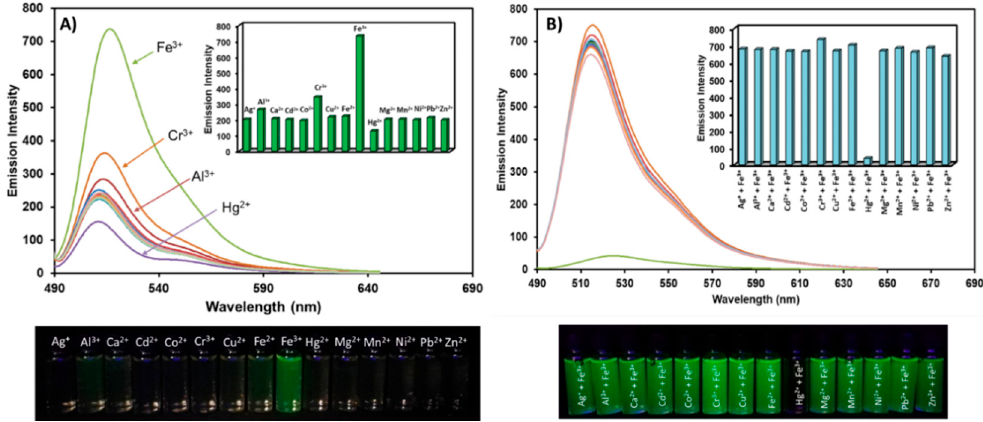
Figure 5. ( A ) The fluorescence spectra of BODIPY-PH in the presence of various metal cations (10 equiv.) and the images BODIPY-PH (10 µM) upon addition of those metal ions. The inset displays bar charts of fluorescent intensities at 518 nm of BODIPY-PH after additions of metal ions. ( B ) The fluorescence spectra of BODIPY-PH in the presence of Fe 3+ co-existing with other metal ions and the images BODIPY-PH (10 µM) in the presence of Fe 3+ co-presenting with those metal ions. The inset shows bar charts of fluorescent intensities at 518 nm of BODIPY-PH in the existence of Fe 3+ co-presenting with other metal